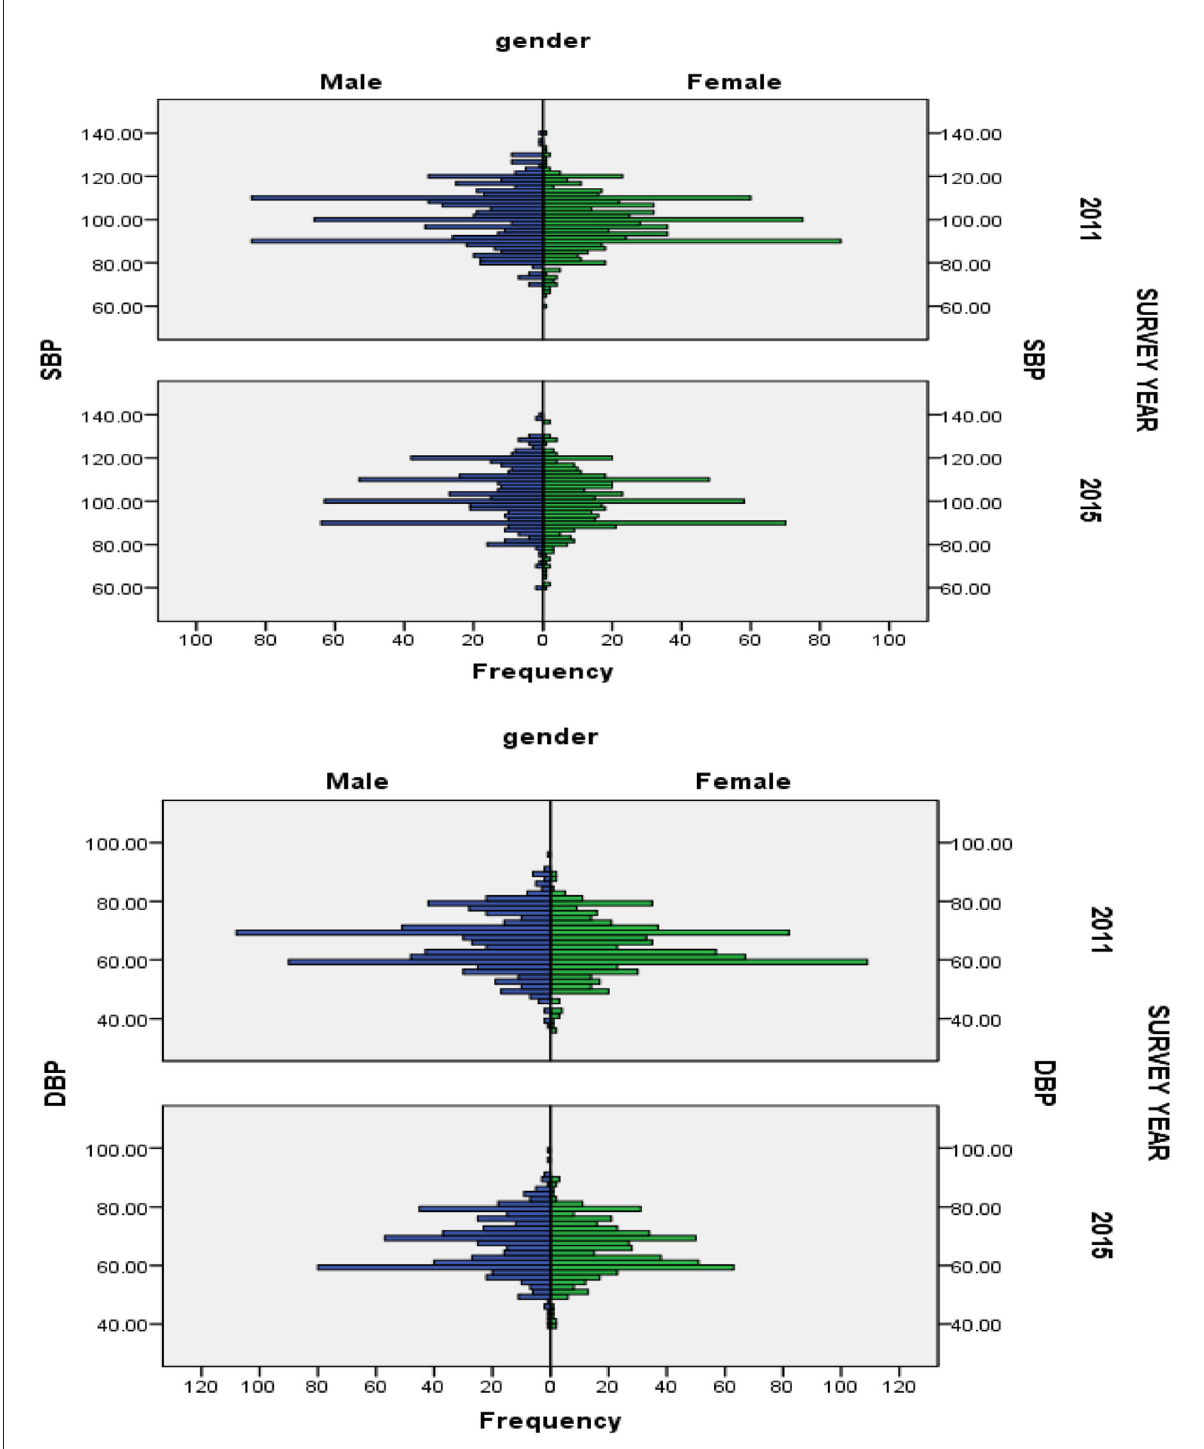
FIGURE2 Secular trend of blood pressure distribution (SBP and DBP) in different gender aged 7–17 years in China,